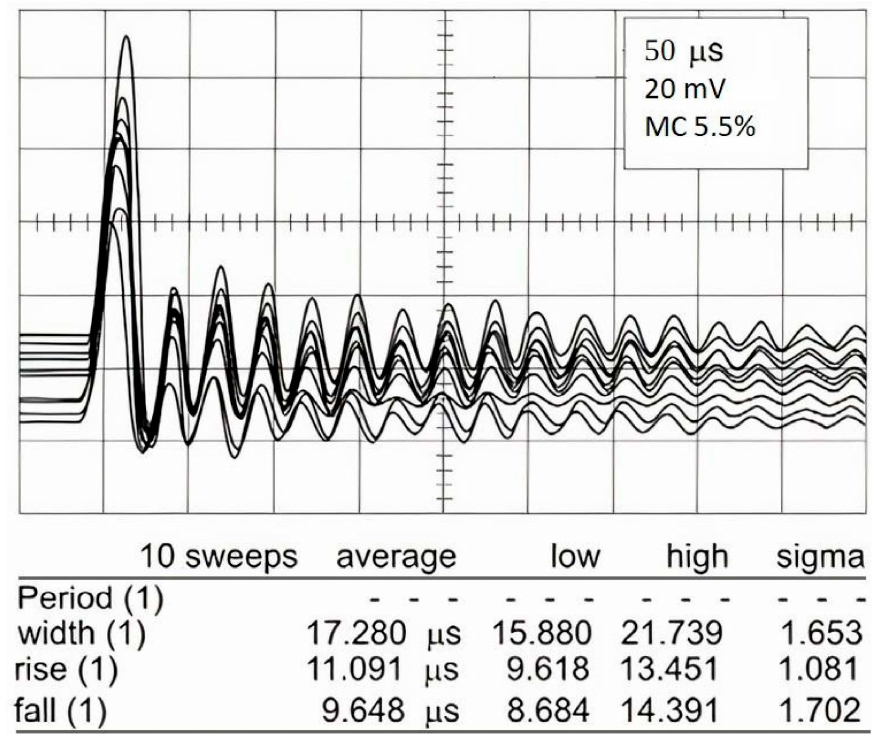
Figure 2. Courses of the signal measuring the impact force of rapeseed about moisture content (MC) 5.5% falling from a height of 0.2 m into a piezoelectric force sensor, [17].